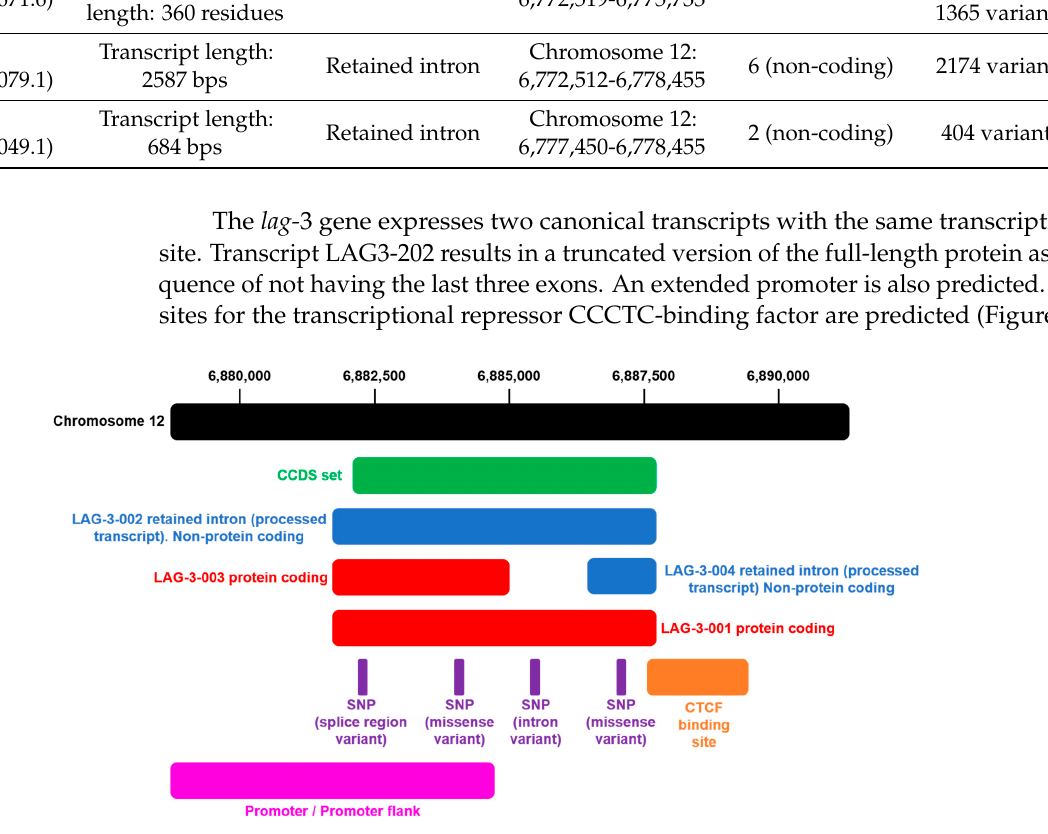
Figure 4. Genomic annotations of the Lag- 3 gene locus. The Lag- 3 locus is located at chromosome 12: 6,881,678-6,887,621 forward strand. The illustration shows the organization of the Lag- 3 locus (http://grch37.ensembl.org/Homo_sapiens/Gene/Summary?db=core;g=ENSG00000089692;r=12:6881678-6887621) [62]. The black bar represents chromosome 12, with positions indicated on top. In green is the Lag- 3 coding region. In blue is the transcript retaining one intron. In red is the canonical Lag- 3 transcript. In red and blue is the alternatively-spliced Lag- 3 transcript. The positions of single-nucleotide polymorphisms are shown below the canonical Lag- 3 transcript. The promoter regions are also indicated in pink.